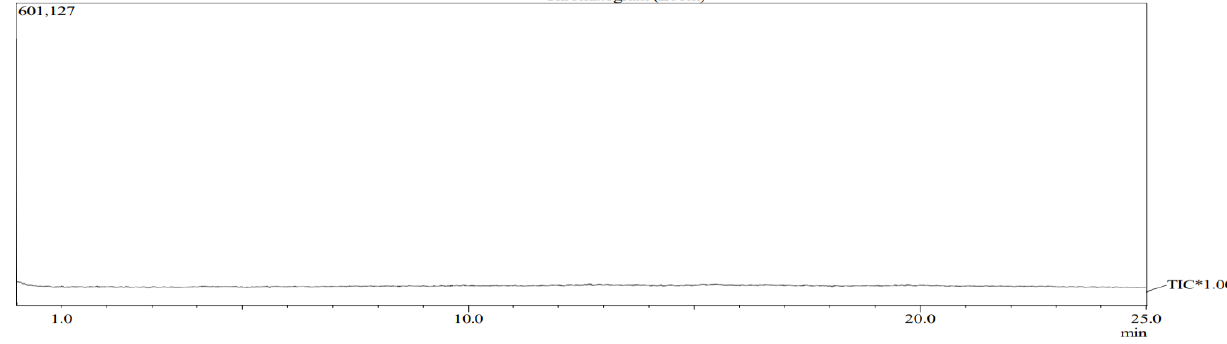
Figure 8. Chromatogram of standard material analysis. Figure 9. The chromatogram analyzing the 3–4 pm measurement point, the measuring point 5 of Business site A.